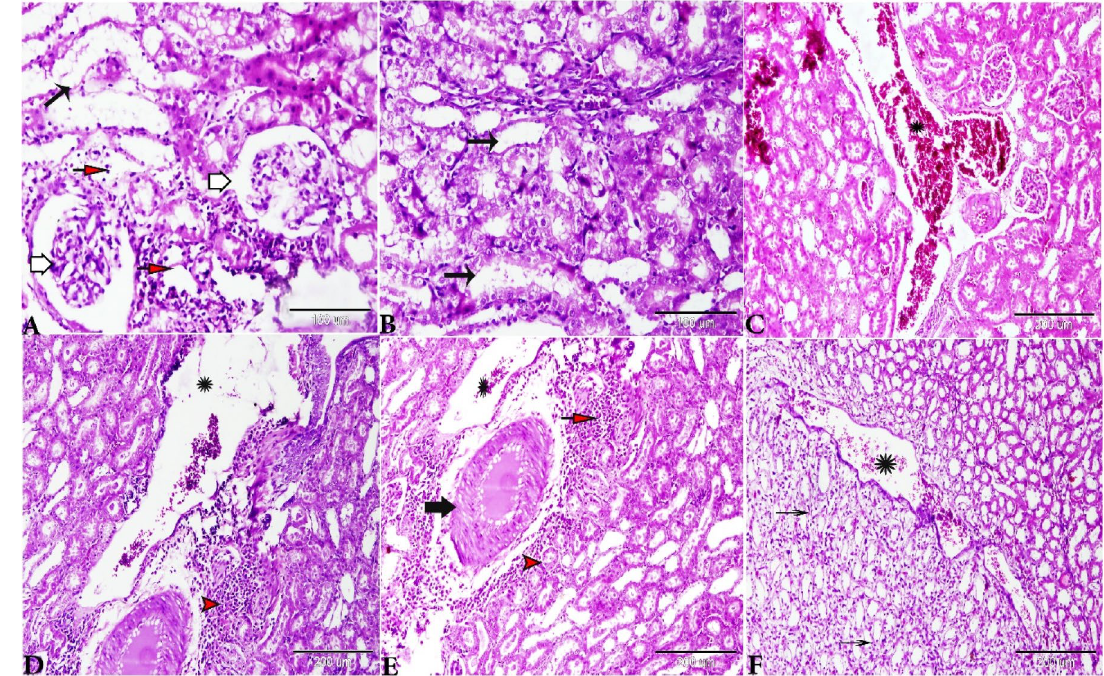
Figure 5. Photomicrograph of the rat kidneys of Group IV (basal diet 70% + cheese containing L. rhamnosus 30%). ( A ) Glomerular atrophy; BS widened and glomerulus showing necrobiotic changes (white arrows), renal tubules dilated with degeneration and necrosis of its epithelial lining (black arrow), interstitial mononuclear cellular infiltration (red arrows). ( B ) Disorganization and degeneration of renal tubules and vacuolation of the lining epithelium (black arrows). ( C , D ) Severe vascular dilatation and congestion (stars). Focal areas of mononuclear cellular aggregations (c, red head arrows). ( E , F ) Severe vascular dilatation and congestion in the corticomedullary junction (stars), fibrinoid degeneration of vascular wall (black arrow), severe perivascular focal mononuclear cellular aggregations (red arrow). ( F ) Degeneration in the renal medullary epithelium (arrows). H&E stain, the bar size was indicated under